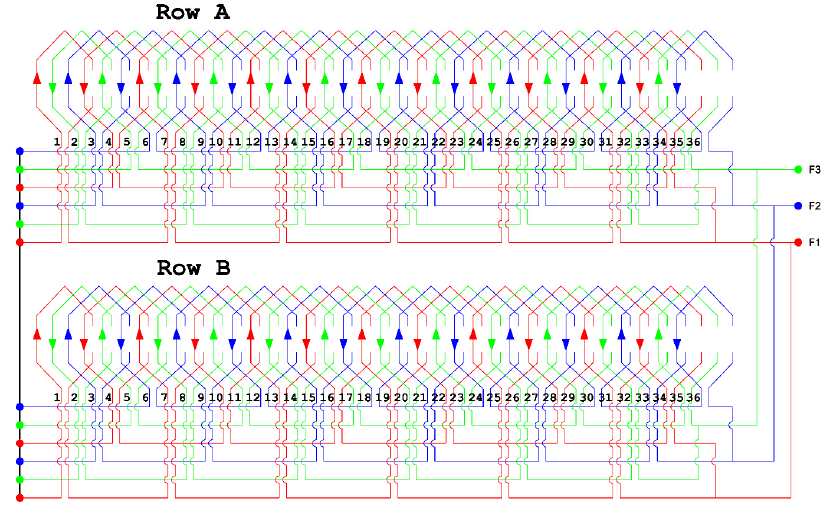
Figure 8. Three-phase connection of the generator.